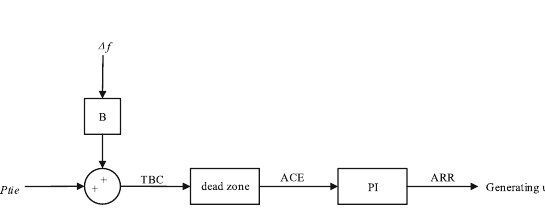
Fig. 3 ACE and ARR signals for regulation